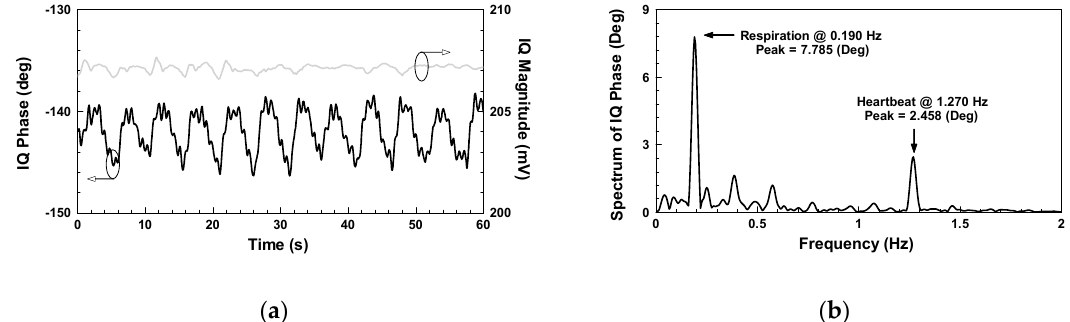
Figure 7. Vital sign detection results using the SIL radar: ( a ) IQ magnitude and phase; ( b ) Spectrum of IQ phase in Figure 6a.